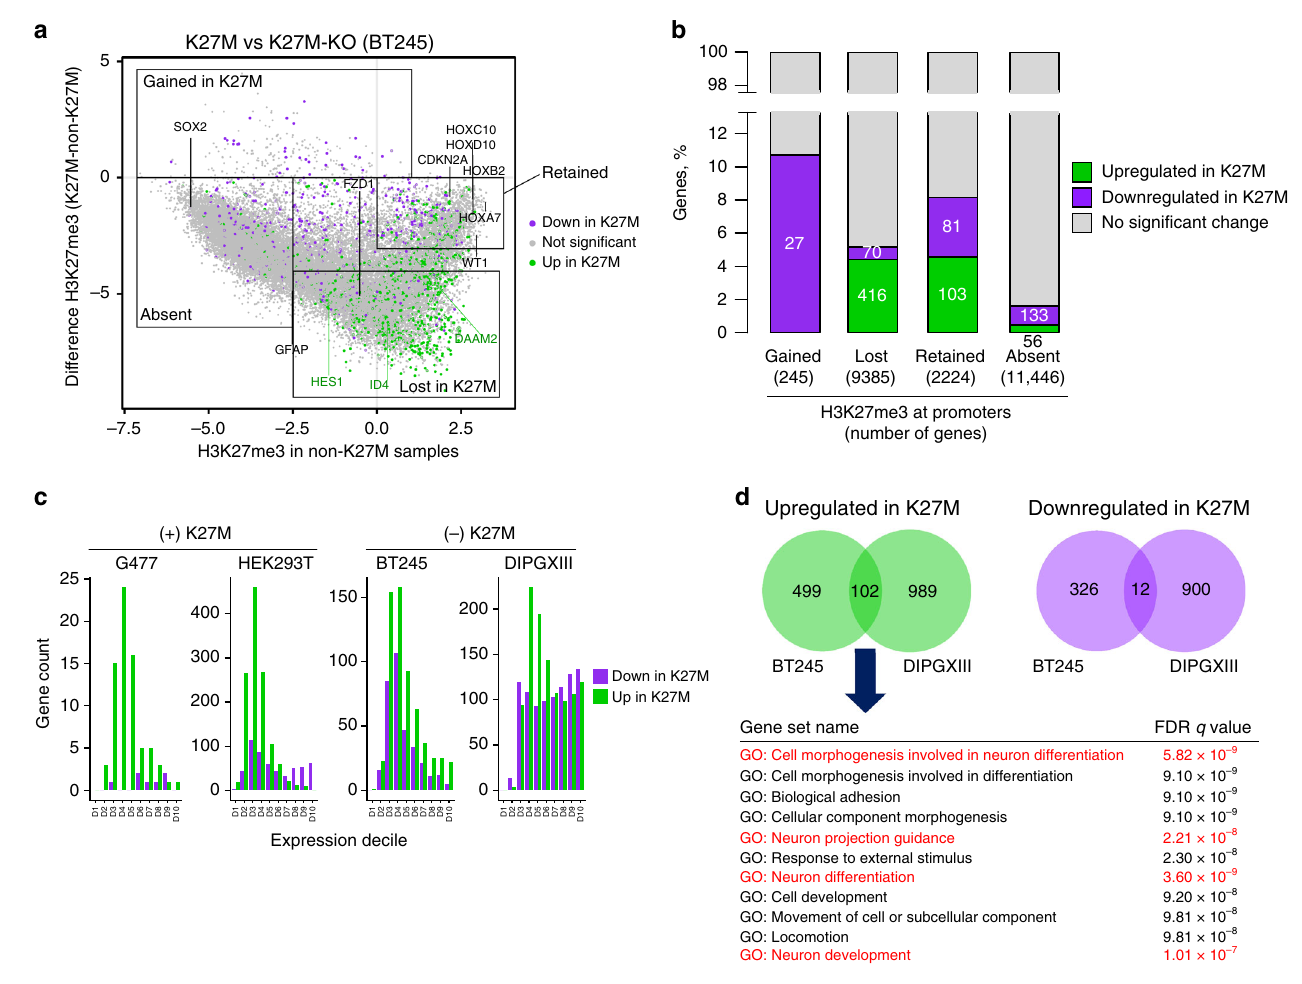
Fig. 4 Transcriptome and H3K27me3 loci implicate H3K27M in neural differentiation a H3K27me3 level difference plot in BT245 dataset, color coded by gene expression changes (green for upregulated in K27M state, purple — downregulated, grey — no signi fi cant change in expression). y- axis shows the difference in normalized H3K27me3 levels at promoters in K27M vs. K27M-KO (log2), while x- axis shows normalized H3K27me3 levels in non-K27M state (K27M-KO, log2). Four categories of promoters based on H3K27me3 levels and difference are depicted by squares. b Number and proportion ( x- axis) of signi fi cantly up or downregulated genes in each selected region from plot 4a (gained in K27M, lost in K27M, retained, absent). Numbers inside the columns show the number of genes up or downregulated in each category, while the number in brackets below column labels shows the total number of genes in that category. c Gene expression changes by deciles in different experimental datasets. The genes were assigned to deciles according to their expression in the original cell line, before manipulation. Most of differentially expressed genes (and upregulated in K27M) are among lower expressed deciles in all four datasets. d Overlap of differentially expressed genes in BT245 and DIPGXIII datasets. Gene set enrichment analysis of differentially expressed genes (genes upregulated in K27M state in both cell